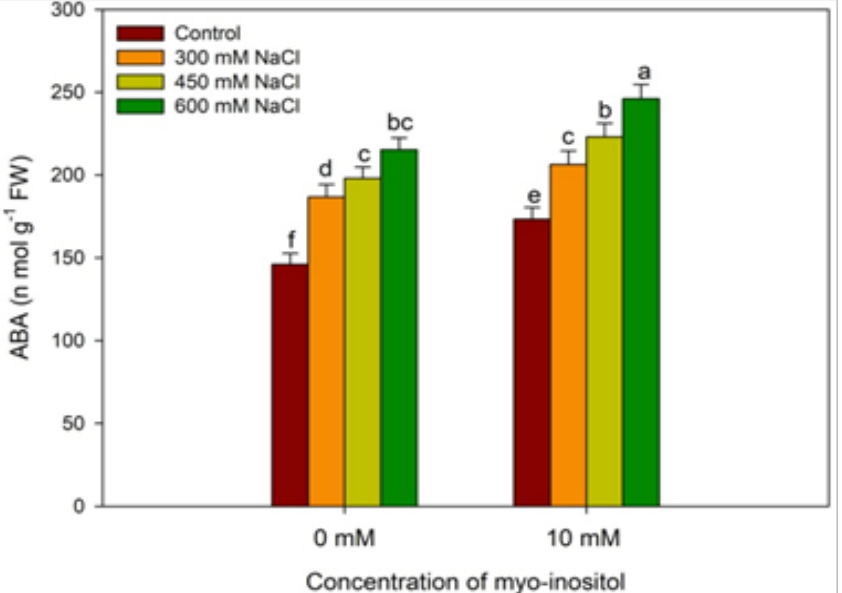
Figure 4. Effect of different salinity (300, 450, and 600 mM NaCl) concentrations with and without exogenous application of myo-inositol (10 mM) on changes in abscisic acid (ABA) in Quinoa ( Chenopodium quinoa L. var. Giza-1). Values are mean ( ± SE) of four replicates, and different letters represent significant differences at p ≤ 0.05.